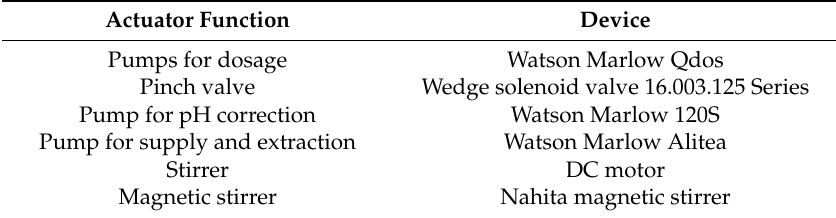
Table 2. Summary of actuators and devices for the